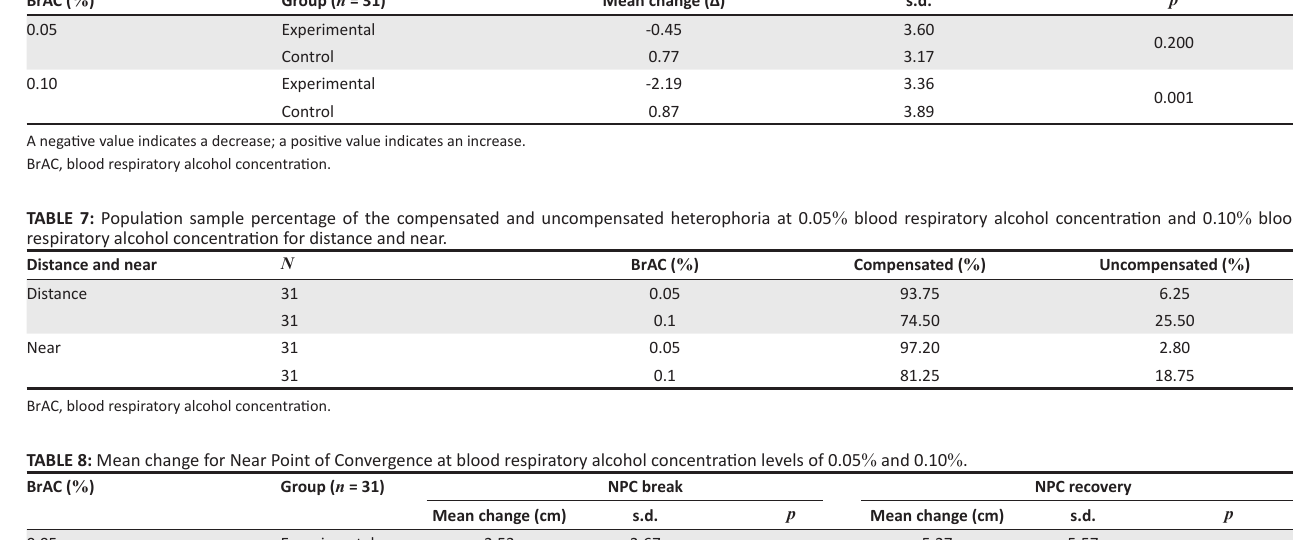
TABLE 6: Mean change for negative fusional vergence at near for blood respiratory alcohol concentration levels of 0.05 % and 0.10 % . BrAC ( % ) Group ( n = 31) Mean change (∆) 0.05 Experimental -0.45 0.10 Experimental